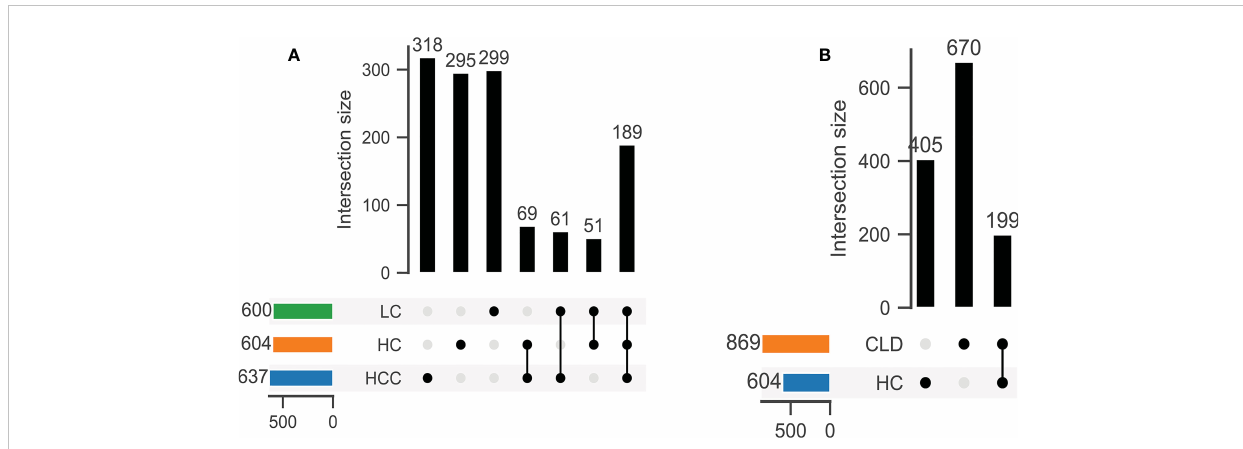
FIGURE 1 The number of common OTUs was signi fi cantly different between healthy control (HC) and CLD (HBV-LC, HBV-HCC) groups. (A) healthy control, HBV-LC, and HBV-HCC group; (B) healthy control and CLD